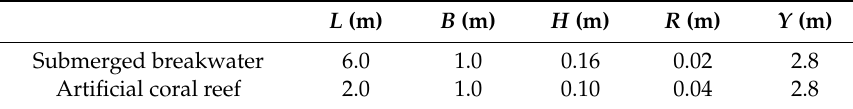
Figure 1. 3D hydraulic experiment composition and structure placement: ( a ) slope composition, ( b ) central particles size of the sand in the upper layer ( d 50 ), ( c ) plane placement of the submerged breakwater (Case 1), ( d ) plane placement of the hybrid method (Case 2), and ( e ) cross-section scheme of experimental structure (Case 2). Table 1. Specification of the 3D hydraulic